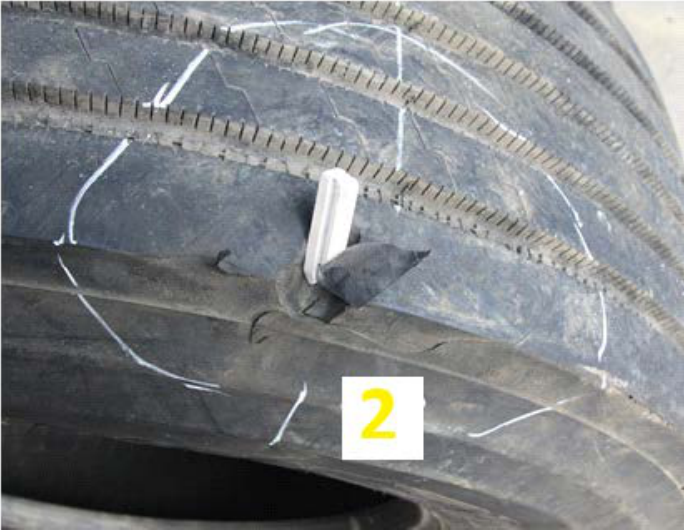
Figure 8. Local loss of tire material on the forehead of the tread on its outer side.